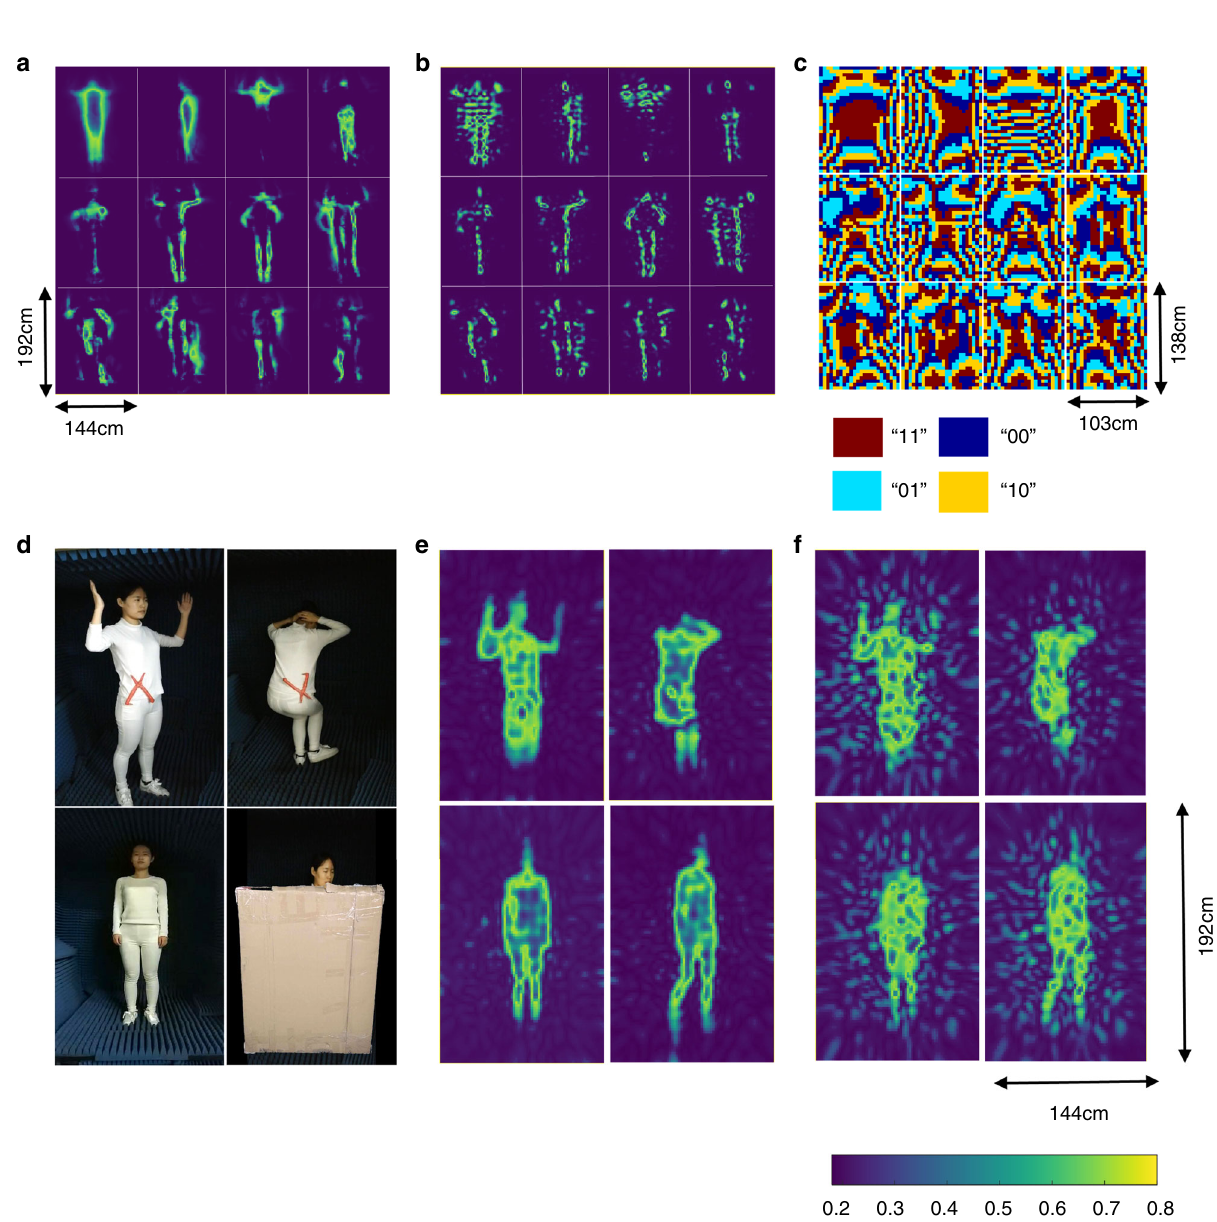
Fig. 2 Con fi gurations and results for human body imaging. ( a ) and ( b ) report 16 leading modes of theoretical PCA and the corresponding experimental patterns radiated by the machine-learning imager, respectively. c shows the coding patterns of 2-bit coding metasurface corresponding to b . d shows four images of a testing person (Ya Shuang, coauthor), where the top two images are armed with glass scissors, as shown in red. e and f are the reconstructed images corresponding to d using the machine-learning imagers trained with PCA and random projection, respectively, where 400 measurements are used. Note that the image results have been normalized by their own